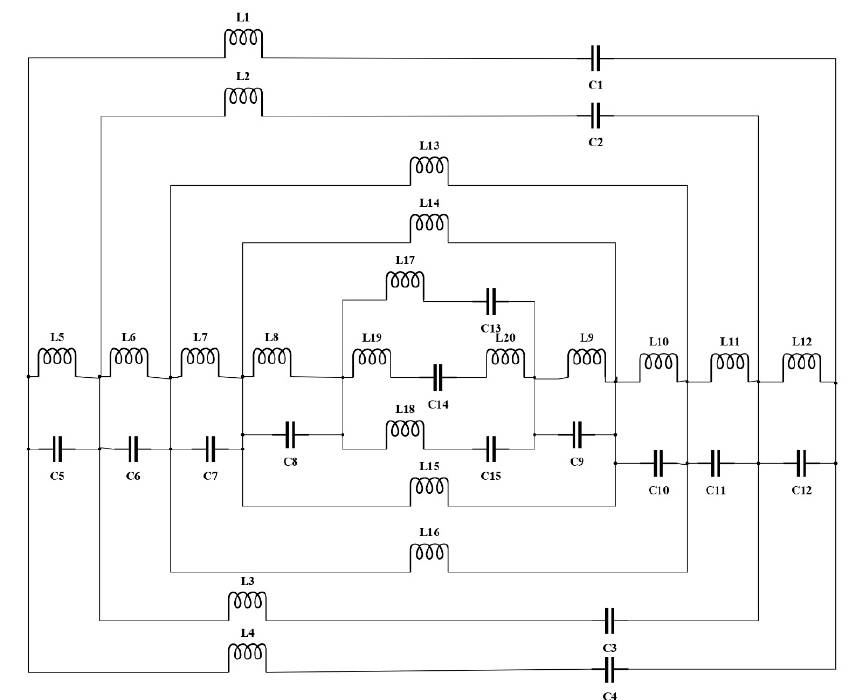
Figure 4. The equivalent circuit model of the proposed metamaterial.